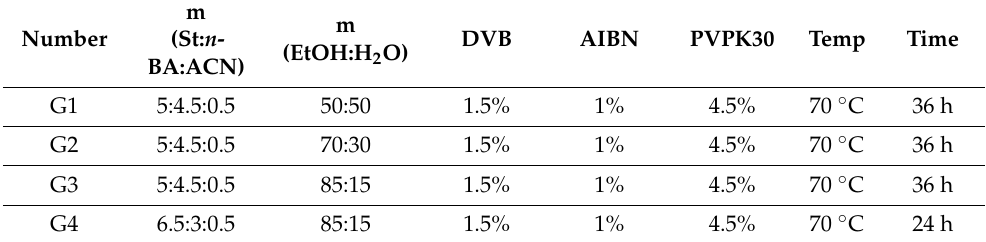
Table 1. The synthetic formula of polymer particle adhesive.